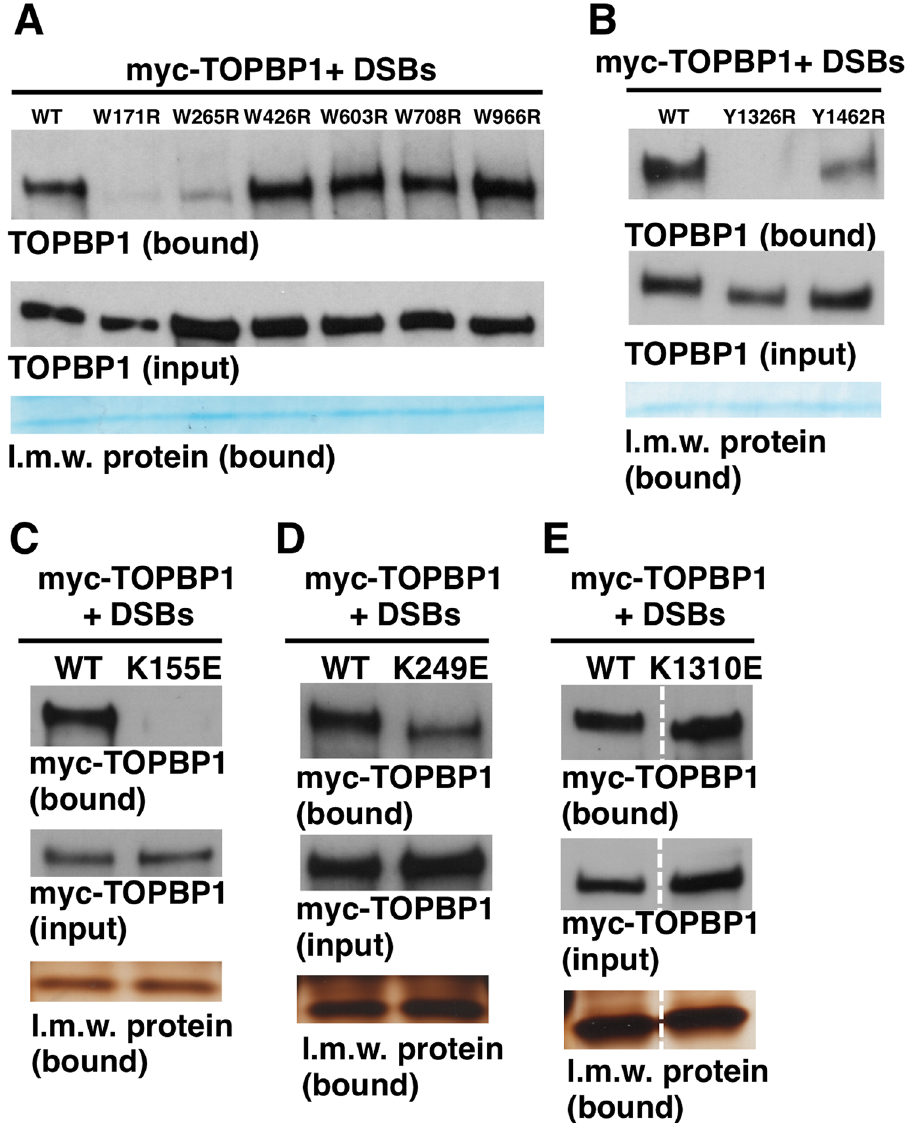
Figure 5. Mutational analysis of the roles of individual BRCT domains in recruitment of TOPBP1 to DSBs. ( A ) HSS was combined with IVTT-produced and myc-tagged TOPBP1 proteins. These proteins were the wild type form (“WT”) and the W to R BRCT domain misfolding mutants shown in Fig. 1. The numbers above the blot reflect the given BRCT domain containing the W to R mutation. DSB beads were then added and the samples were incubated for 60 min. After incubation, the beads were processed as in Fig. 3B and the samples were probed for the indicated protein. The myc antibody was used to probe for TOPBP1. The bound samples were also stained by Coomassie and the ~ 12.5 kDa l.m.w protein is shown. ( B ) Same as ( A ) except the Y to R BRCT misfolding mutants were analyzed. ( C–E ) Same as ( A ) except the indicated PBP mutant was analyzed. The l.m.w. protein was visualized by silver staining. For ( E ), the dashed white line on the blots demarcates a lane from the original image that was removed because it is irrelevant. All samples shown were run on the same gel and blotted together on the same membrane at the same time. See Fig. S1 for the original